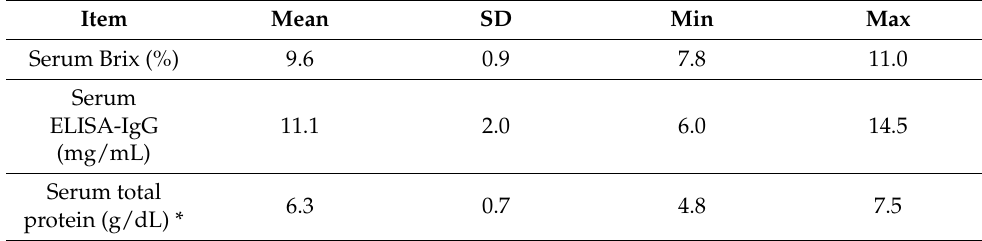
Table 2. Descriptive statistic of calves’ serum ( n = 26) obtained at T3 (3 days after birth).